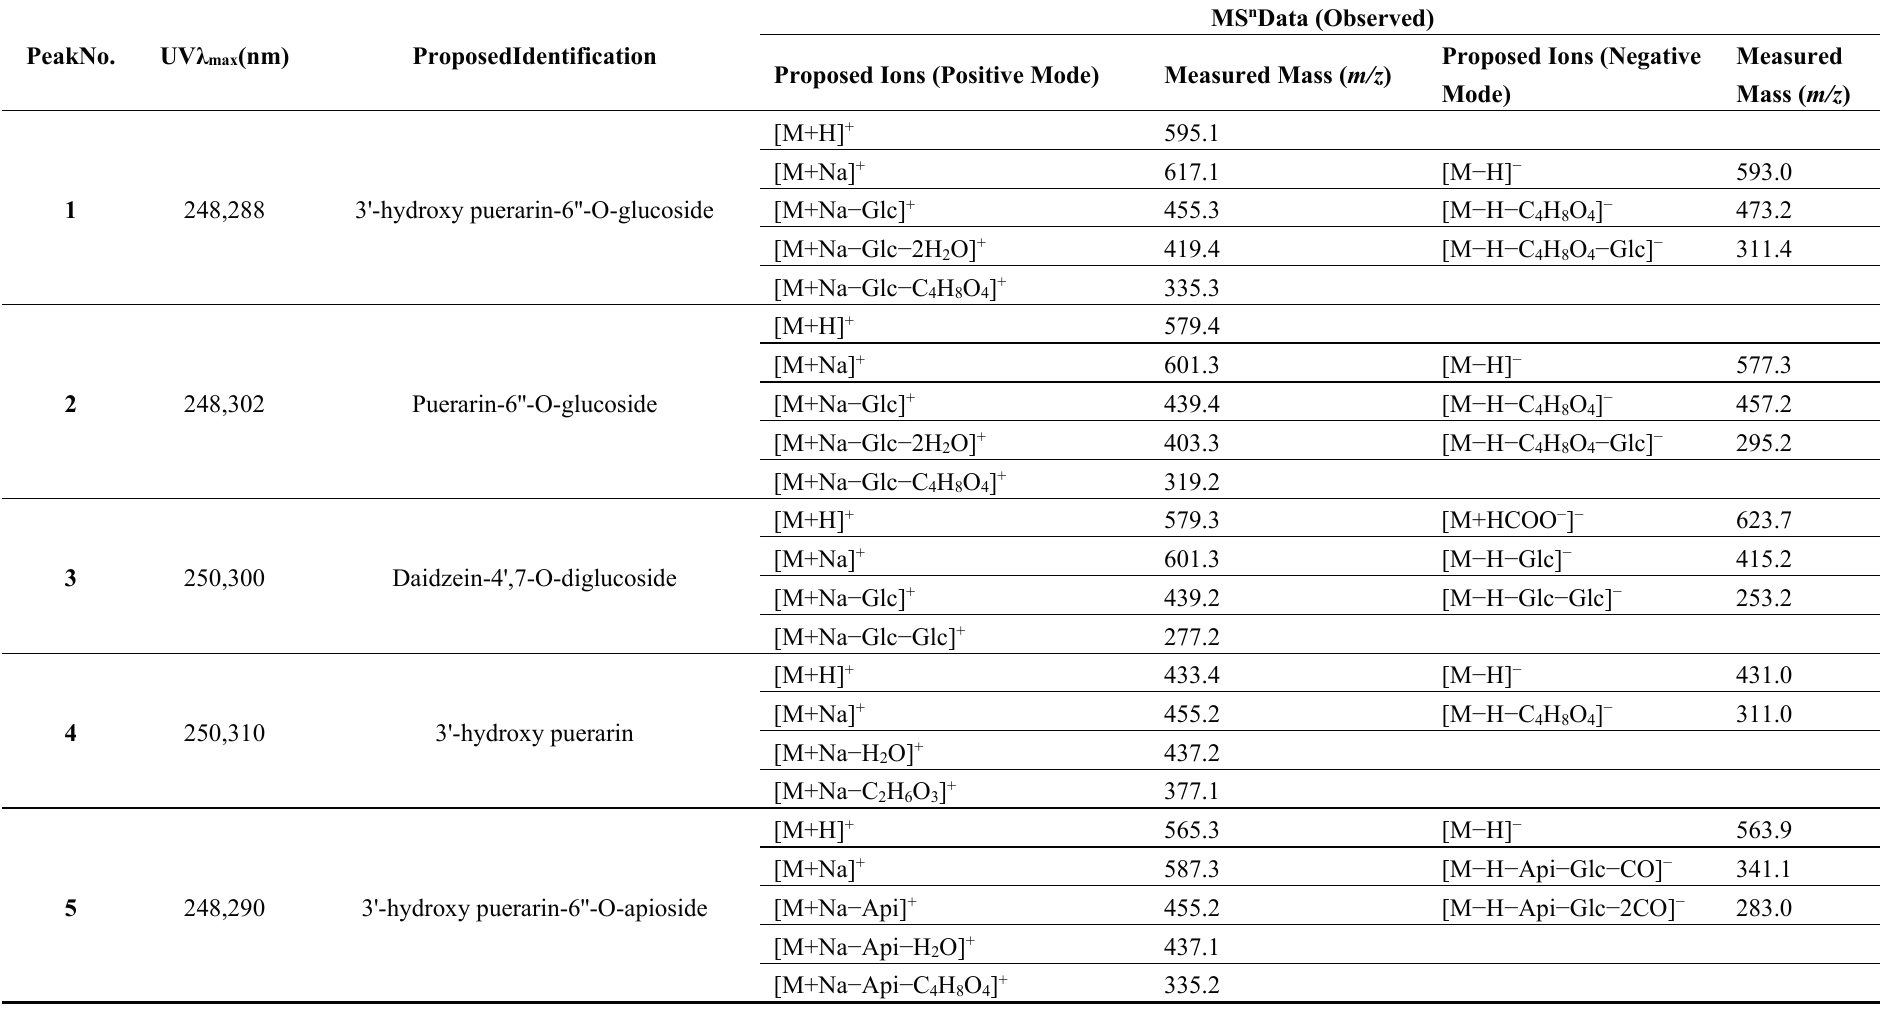
Table 1. MS n structural information of the nine compounds in both positive and negative ion